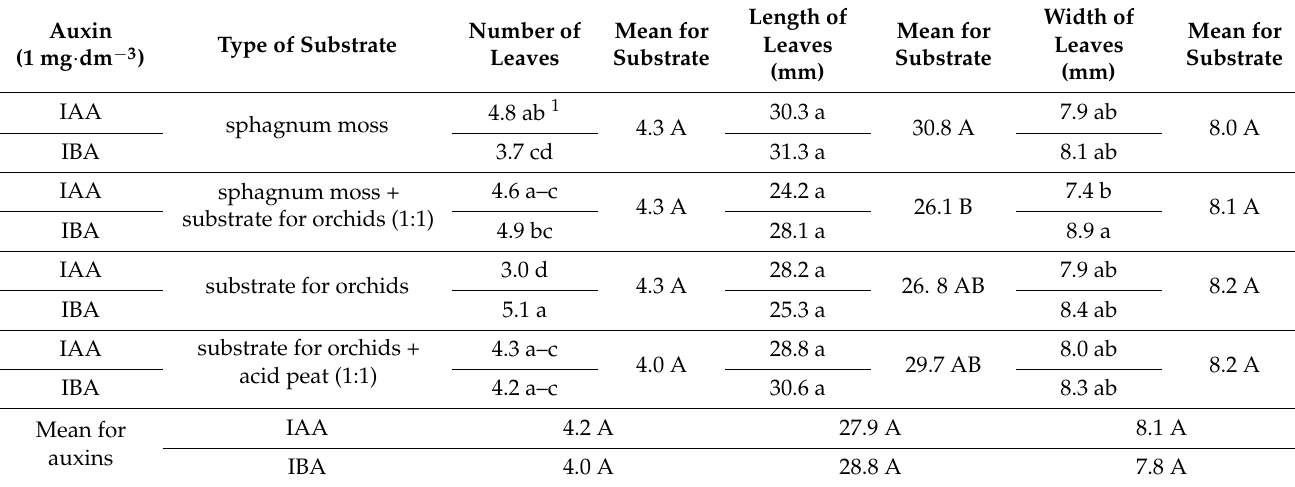
Table 4. The subsequent effect of IAA or IBA and substrate type on the morphological features of the P. insigne plantlets during